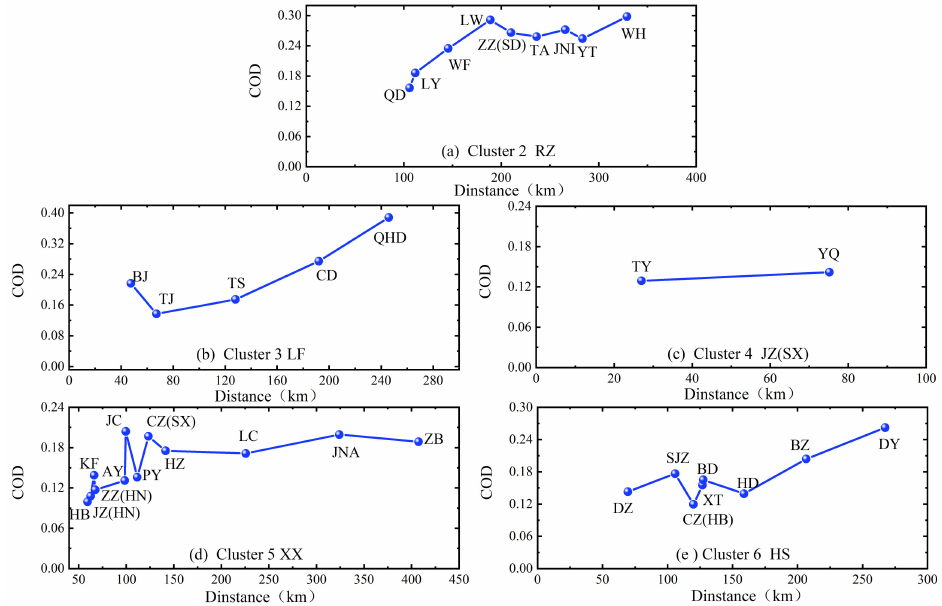
Figure 6. The variations of COD values with the geographical distance of any city relative to the representative city for the five clustered regions ( a – e ) are based on Pearson’s correlation distances